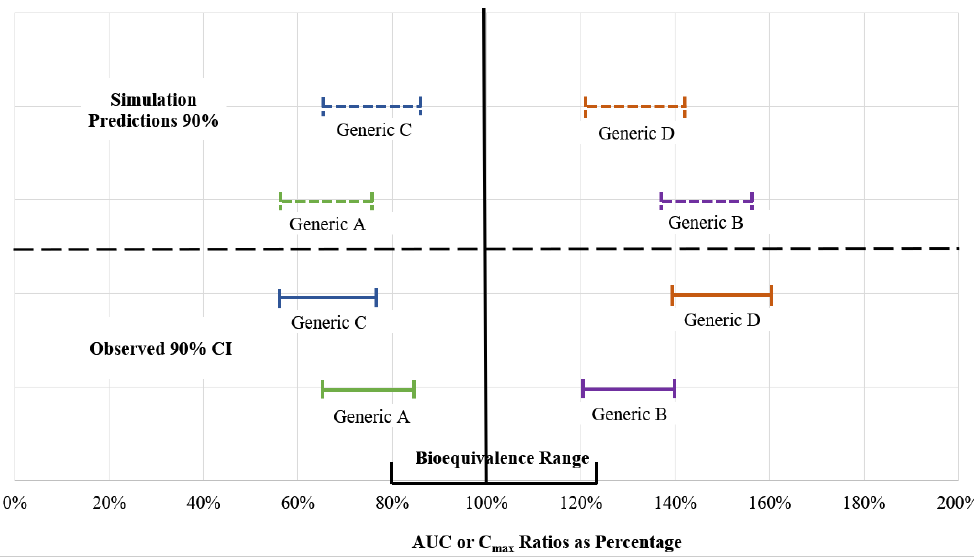
Figure 3. The false predictions of bioequivalence based on the simulation that accept up to 1.25-fold differences between predicted and observed AUC or C max ratios.